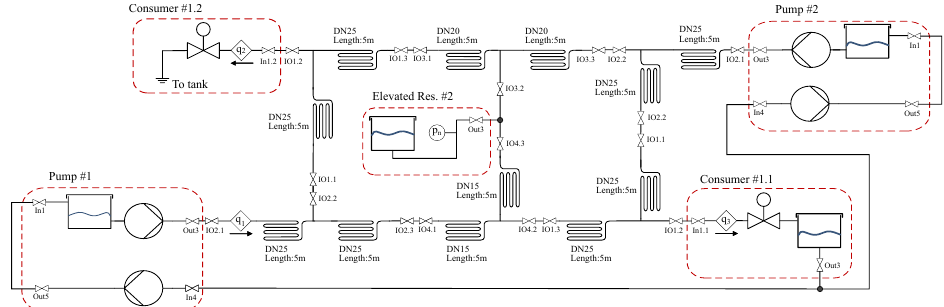
Figure 13. Diagram of the a ring topology water distribution network that is built with laboratory modules. This network is inspired by the structure from Figure